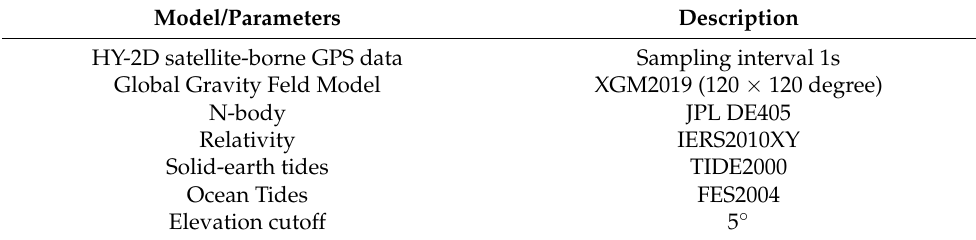
Table 3. Reduced-dynamic orbit determination strategy for